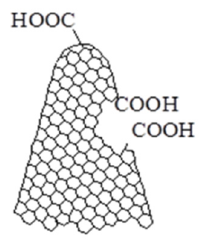
Figure 1. The structure of CNHox.